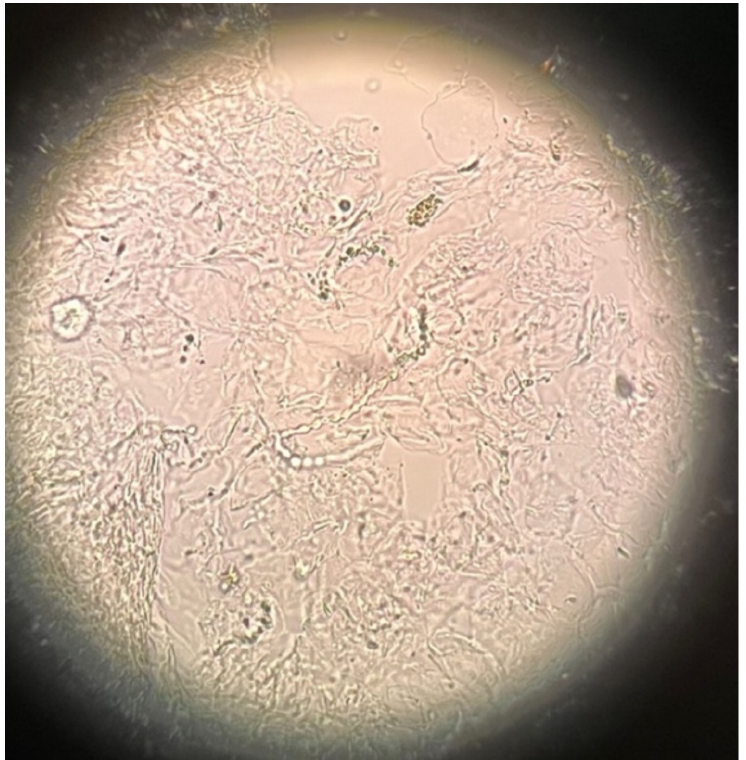
Figure 3. Microscopic mycological examination of the skin scrapings (20 × magnification). Long narrow